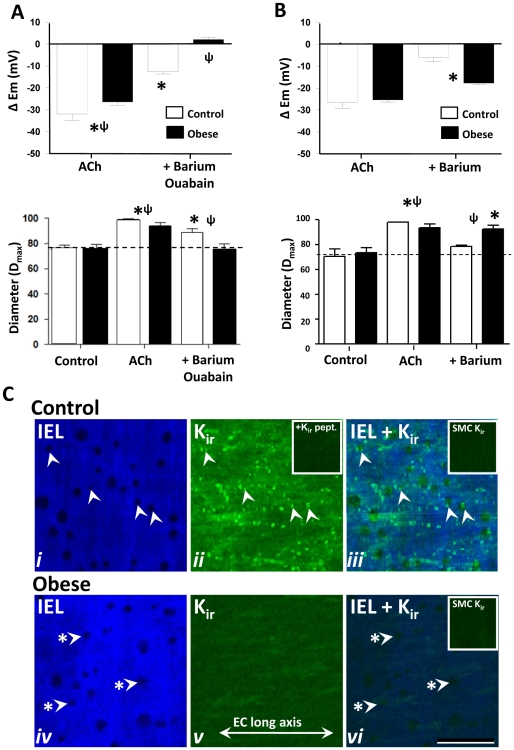
Na+/K+ATPase and Kir activity, and Kir distribution.Combined Na+/K+ATPase and Kir inhibition with ouabain (100 µM) and barium (30 µM), respectively, attenuates ACh-mediated hyperpolarization and relaxation in control, and abolished the response in obese rat vessels (A). In arteries of control, barium alone reduced EDH activity, whilst in obese, barium alone had no effect on vessel diameter, although the ACh-evoked hyperpolarization was attenuated (B; Table S3). *P<0.05 from own control; ψ, P<0.05 control v obese. ΔEm, change in membrane potential from control. Confocal immunohistochemistry demonstrates Kir distribution in control (Ci–iii) and obese (Civ–vi) rat arteries (same region shown in i–iii and iv–vi, respectively). Autofluorescence demonstrates internal elastic lamina (IEL) morphology and associated holes (Ci, iv, examples arrowed) as potential myoendothelial gap junction sites. In control arteries, Kir labelling shows intense punctate localization at discrete points in the endothelium, including in close proximity to a proportion of IEL holes (Cii–iii, examples arrowed); an observation absent in obese rat vessels (iv–vi, arrows with asterisks indicate examples of such sites, vi). Kir labelling was absent in the smooth muscle of both control and obese arteries (insets, Ciii, vi, respectively), whilst endothelial labelling in control was blocked by pre-incubation in Kir antibody antigenic peptide (Cii, inset). Longitudinal vessel axis runs left to right (example, v). Bar, 20 µm.